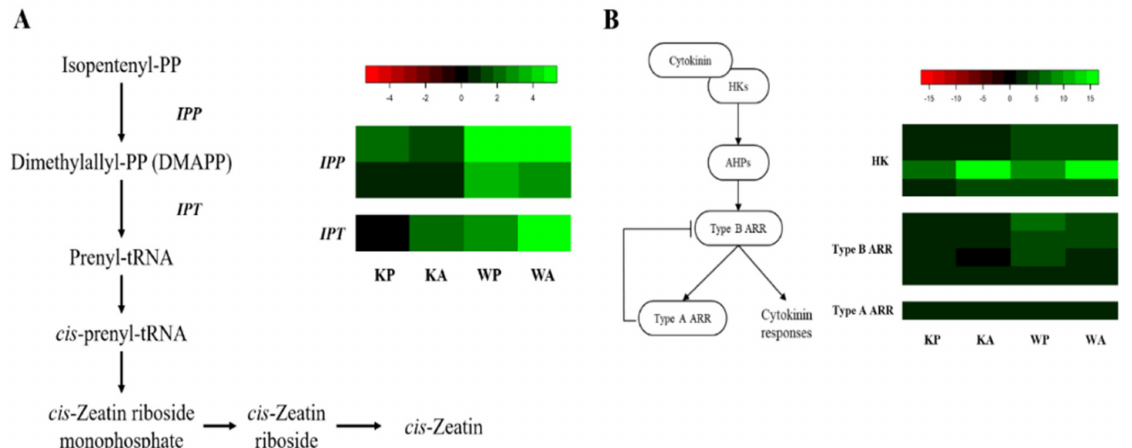
Figure 5. Heat map analysis of DEGs from PHS and ABA treatment for GA hormone metabolism and signaling: ( A ) hor- mone metabolism pathway of cytokinin and comparative expression of genes related to cytokinin hormone metabolism; ( B ) signaling pathway of cytokinin and comparative expression of genes related to cytokinin signaling. The heatmap shows an expression change compared to the controls for each cultivar, with log2 fold-change